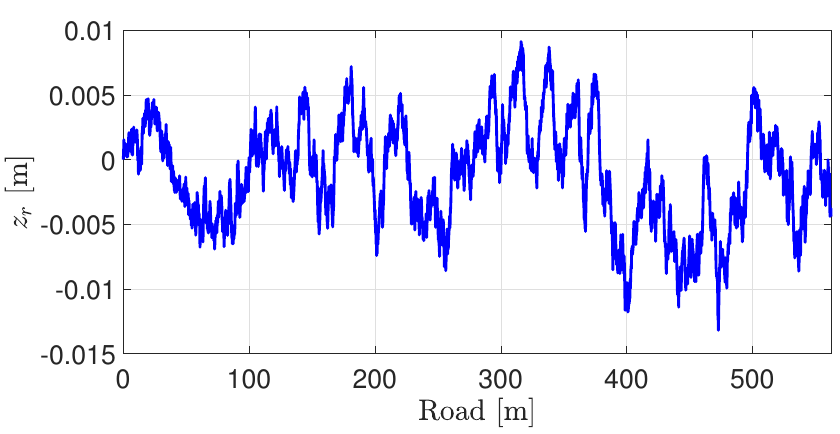
Figure 14. Road input at the front right